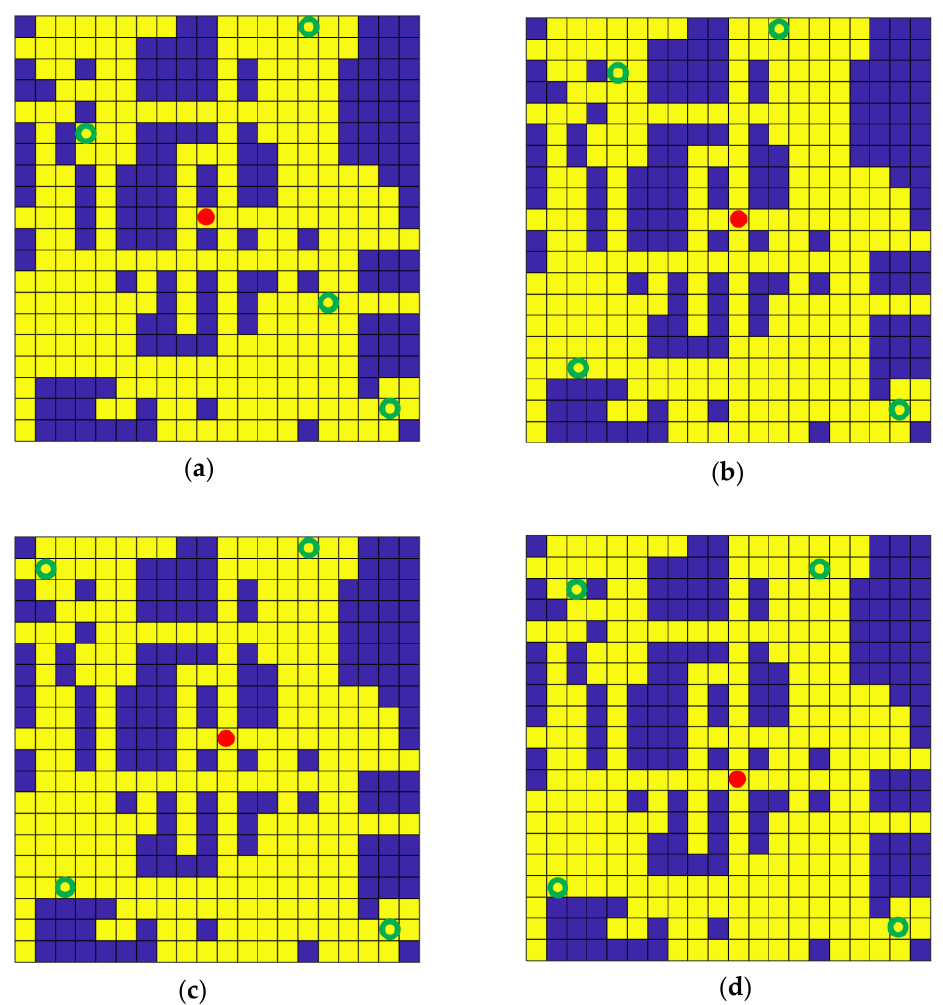
Figure 8. The best individual in ( a ) 1st generation ( b ) 10th generation ( c ) 20th generation ( d ) 40th